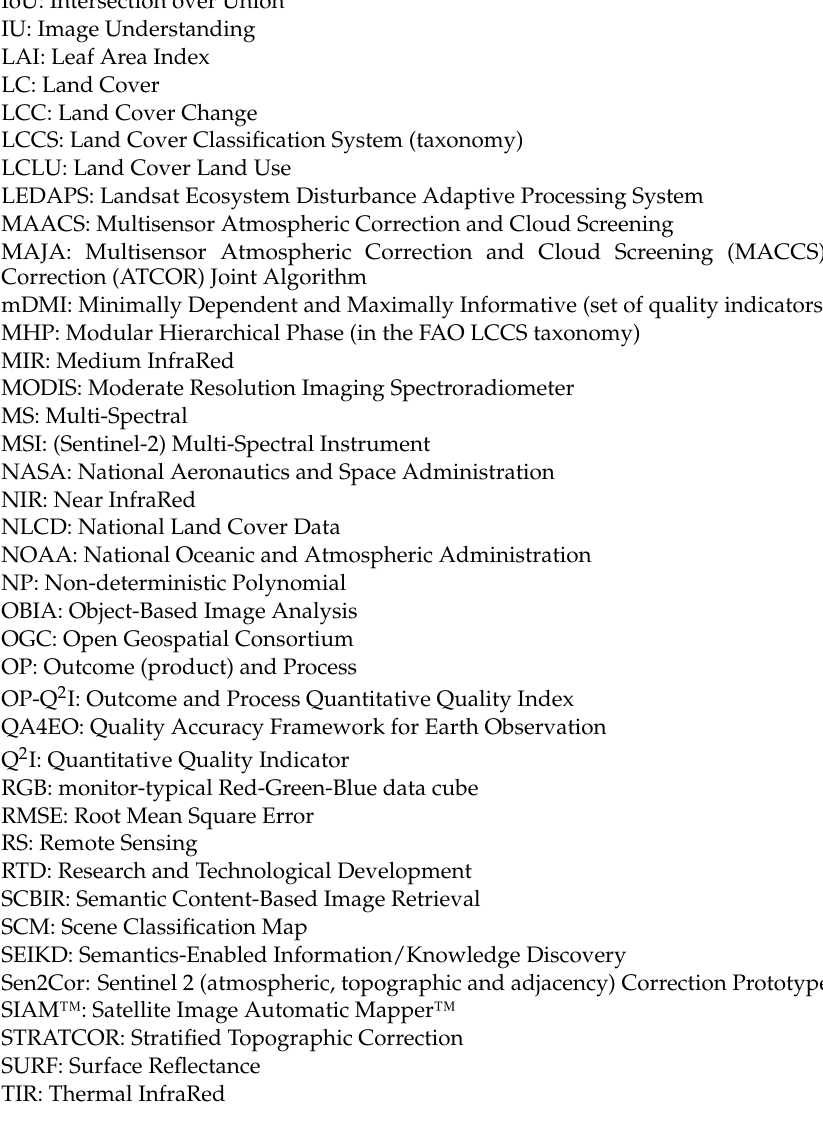
SIAM™: Satellite Image Automatic Mapper™ STRATCOR: Stratified Topographic